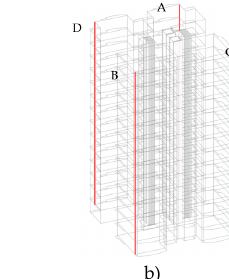
Figure 13. Linear elastic dynamic analysis: a ) accelerogram (direction X); b ) accelerogram (direction Y); and c ) spectral acceleration.